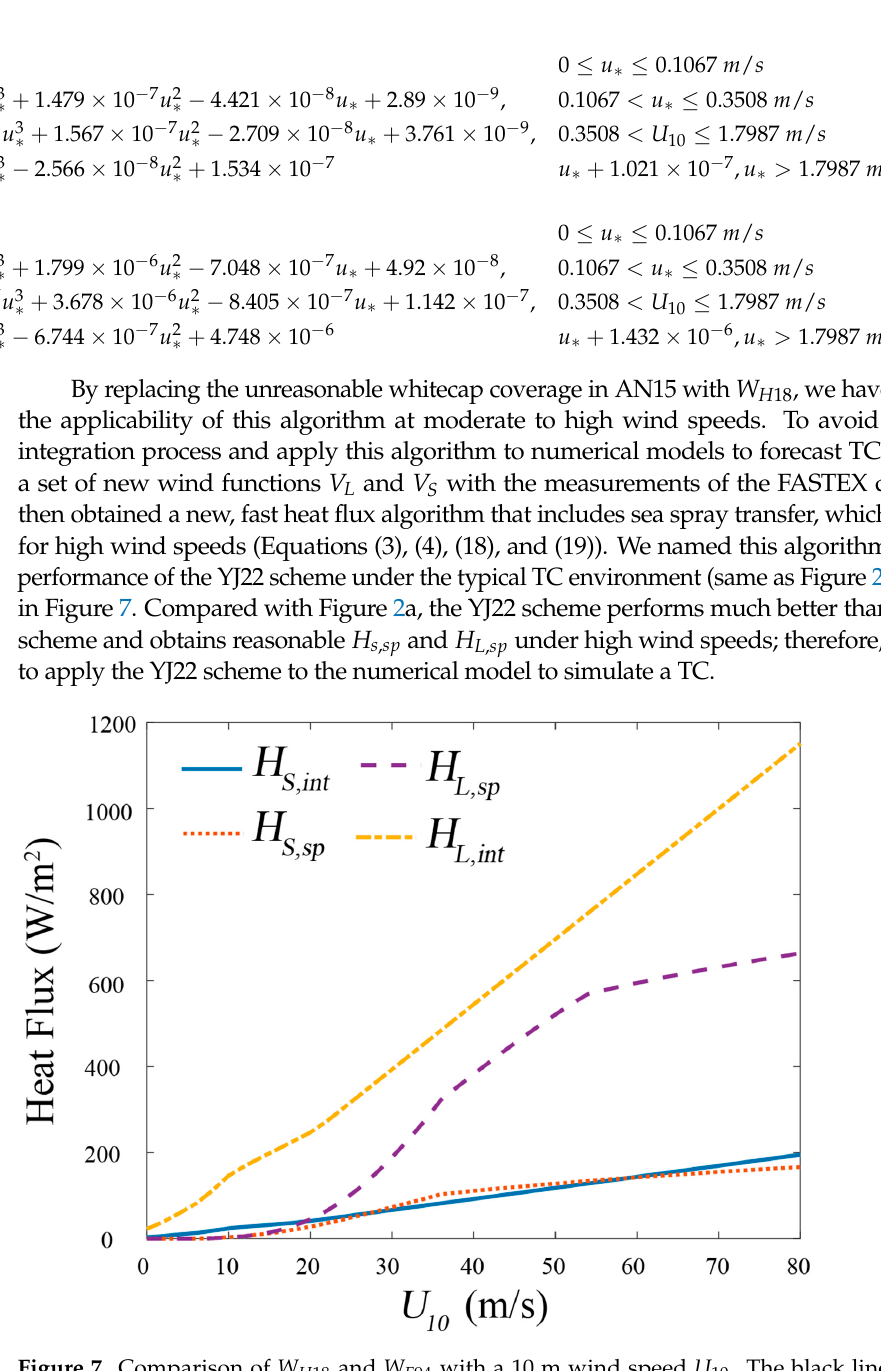
Figure 7. Comparison of W H 18 and W F 94 with a 10 m wind speed U 10 . The black line represents W H 18 , and the blue line represents W F 94 . The TC environment is the same as that in Figure